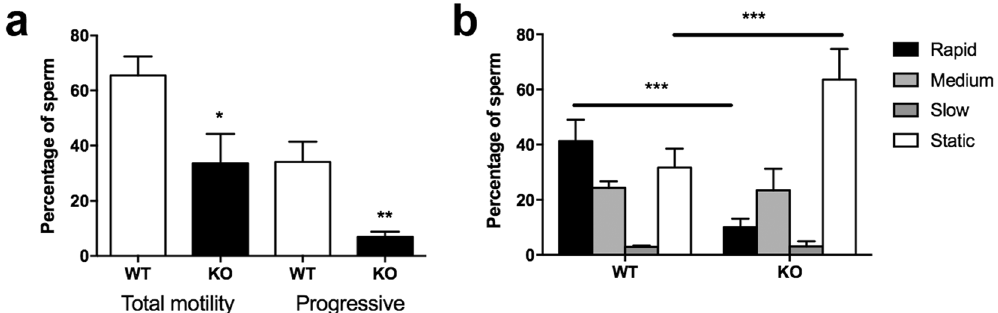
Figure 5. Sperm motility in Plag1 wild-type (WT) and knock-out (KO) mice. ( a ) Motility of spermatozoa from the cauda epididymis of KO vs WT mice aged 11–13 weeks of age ( n = 5). ( b ) Velocity distribution of spermatozoa from KO vs WT mice ( n = 5). Values shown are means ± SEM. * P < 0.05 ( t -test); ** P < 0.01 ( t - test); *** P < 0.001